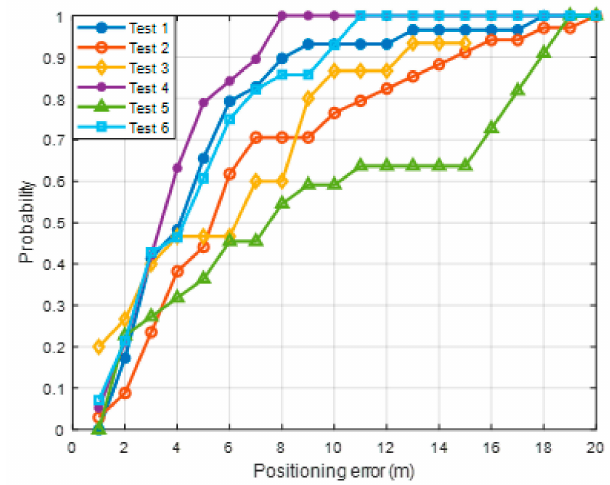
Figure 18. Cumulative distribution function (CDF) for all